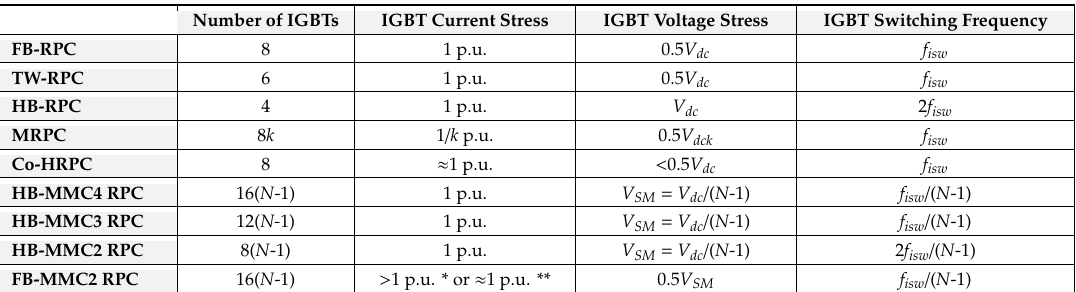
Table 15. IGBT characteristics of the RPC topologies (based on [6–8,10,33]). Number of